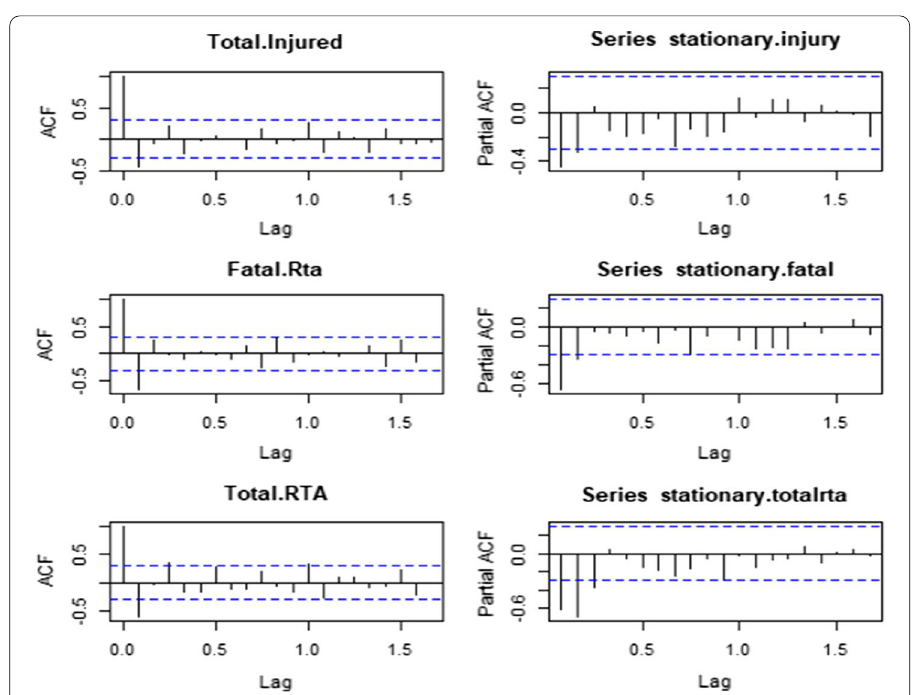
Fig. 5 Autocorrelation and Partial autocorrelation function plots of Injury, Fatal and Total